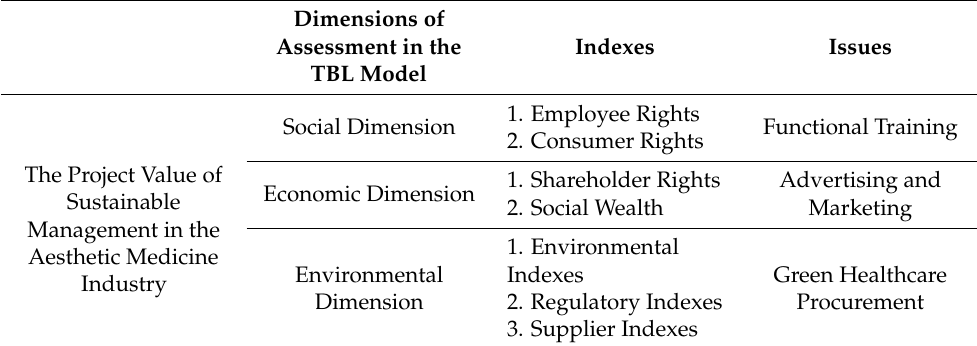
Table 2. The dimensions of sustainable management in aesthetic medicine, with corresponding indices and